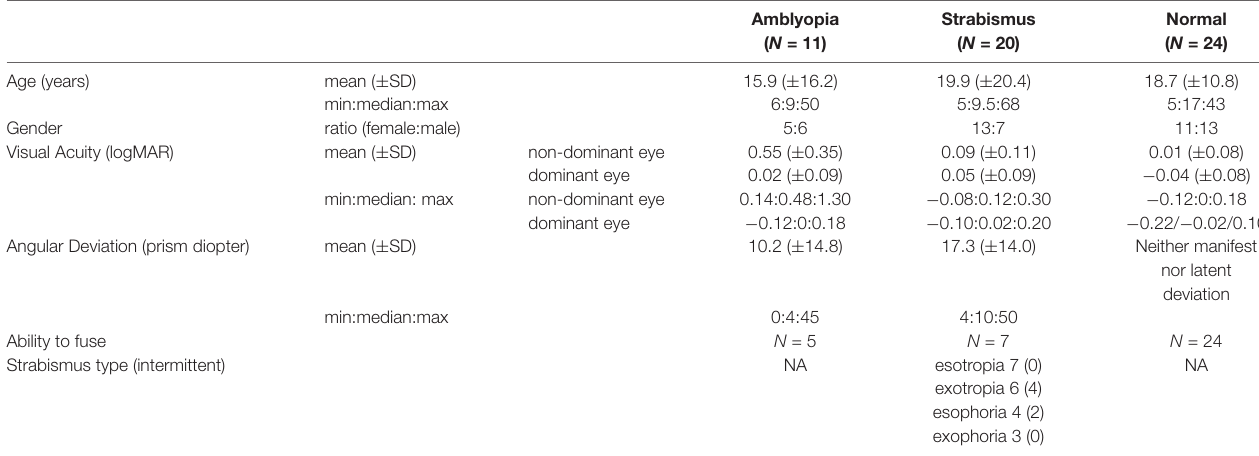
TABLE 1 | Participant